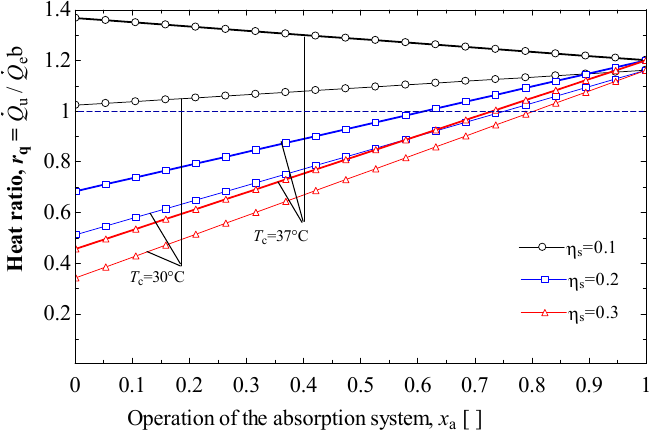
Figure 4. Power ratio of the compressor to solution pump with respect to the operating ratio of the refrigeration systems, x a .